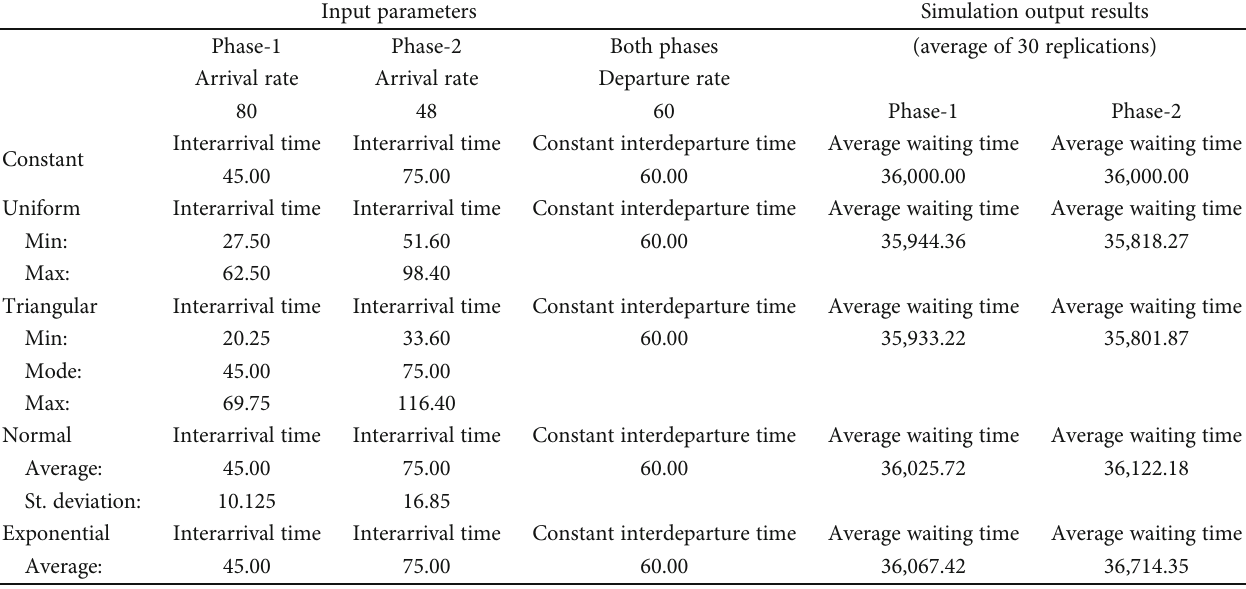
Table 2: Comparison of the average waiting times in phase-1 and phase-2 for four di ff erent interarrival time distributions: uniform, triangular, normal, and exponential. Constant rate refers to deterministic interarrivals. Mean interarrival rates for all distributions in phase-2 are 75 tertias.